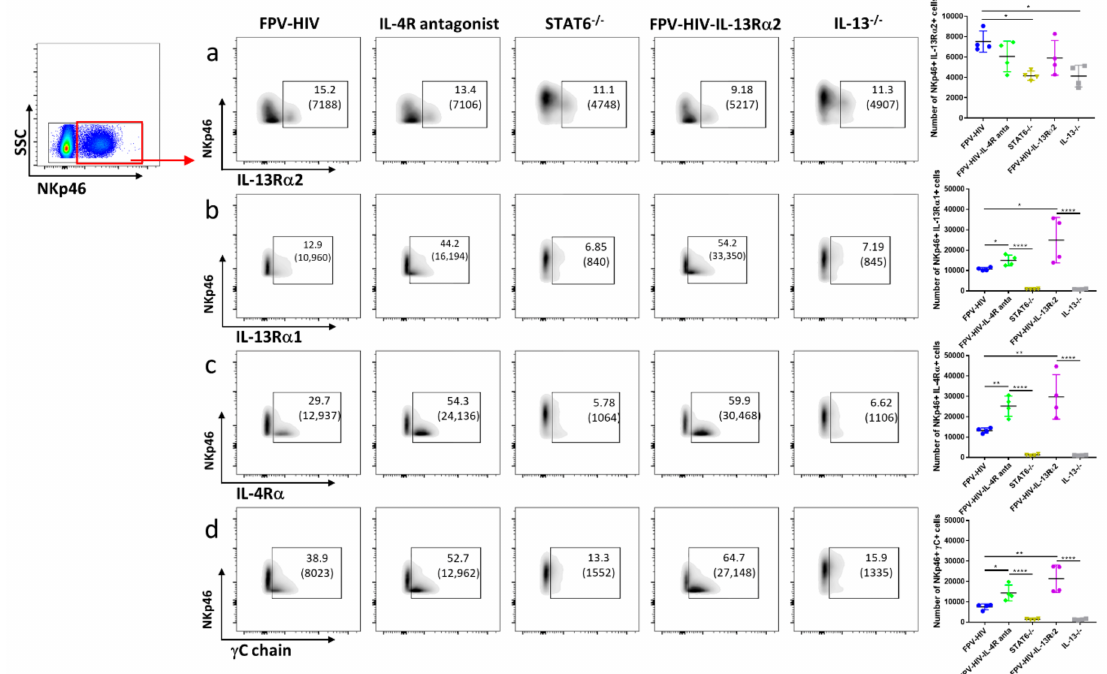
Figure 6. Evaluation of lung lineage − IL-33R/ST2 − NKp46 + ILC1/ILC3 expressing IL-13R α 2, IL-13R α 1, IL-4R α , and γ C receptors following rFPV vaccination under different inhibitory conditions. WT BALB/c mice (n = 4) were immunized intranasally with FPV-HIV-IL-4R antagonist or FPV-HIV-IL-13R α 2 adjuvanted vaccines. STAT6 − / − and IL-13 − / − mice on BALB/c background (n = 4) were immunized with FPV-HIV unadjuvanted vaccine. Color coded vaccine groups represent: blue, WT BALB/c given FPV-HIV (control); yellow, STAT6 − / − given FPV-HIV (which represents permanent STAT6 signaling inhibition condition); green, WT BALB/c given FPV-HIV-IL-4R antagonist vaccine (which represents transient IL-4/IL-13/STAT6 signaling inhibition condition); grey, IL-13 − / − given FPV-HIV (which represents permanent IL-13 inhibition condition); and purple, WT BALB/c given FPV-HIV-IL-13 α 2 adjuvanted vaccine (which represents transient IL-13 sequestration/inhibition condition). Lung NKp46 + ILC1/ILC3 were gated as CD45 + FSC low SSC low lineage − IL- 33R/ST2 − NKp46 + cells. The FACS plots in each panel indicate the percentage of NKp46 + ILC1/ILC3 expressing IL-13R α 2 ( a ), IL-13R α 1 ( b ), IL-4R α ( c ), and γ C chain ( d ). The brackets below the cell percentage indicate the number of cells in each gate. The graph in each panel represents the number of NKp46 + ILC1/ILC3 expressing the different receptors 24 h post vaccination back calculated to CD45 + population, as described in the materials and methods. The error bars represent the mean and standard deviation (s.d.). The p values were calculated using one-way ANOVA using Tukey’s multiple comparisons test and unpaired t -test. * p < 0.05, ** p < 0.01, **** p < 0.0001. Experiments were repeated a minimum of 3